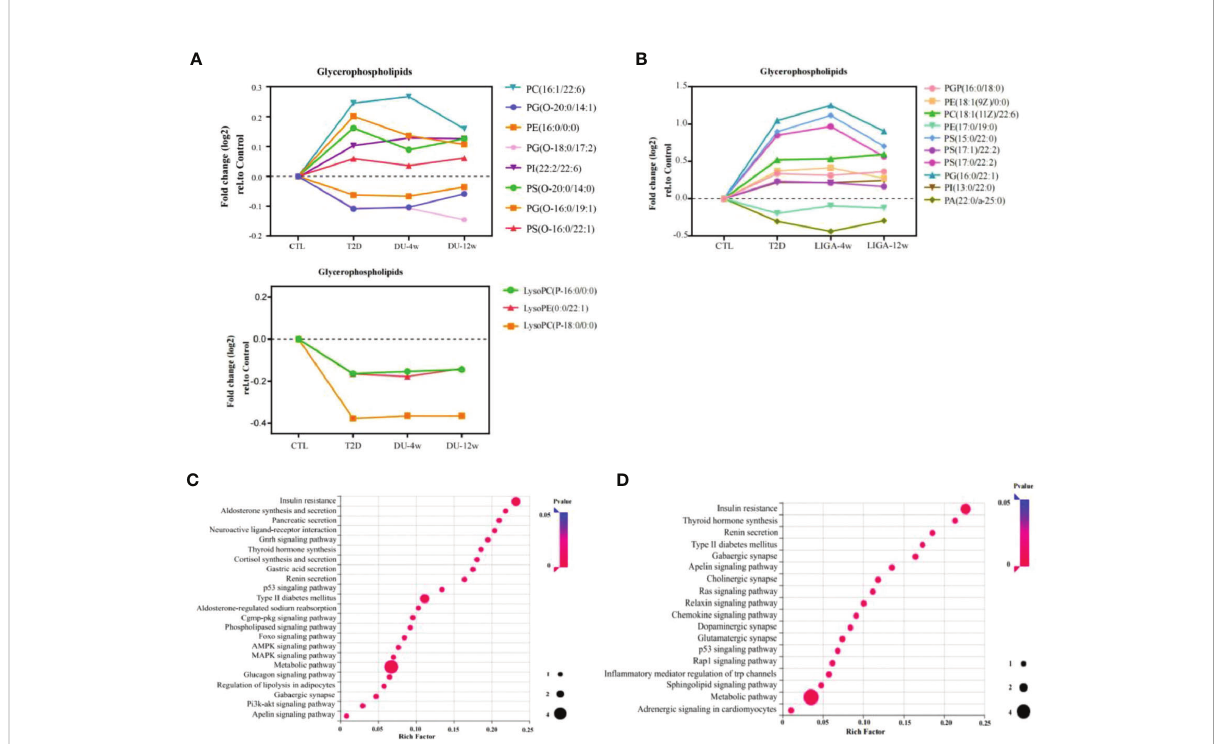
FIGURE 5 Integrating longitudinal analysis concurrent with diabetes case-control status to reveal GLP-1RAs-associated metabolic pathways and potential targets. (A, B) Longitudinal trajectories of signi fi cant metabolites involved in glycerophospholipid metabolism in response to DU and LIGA, respectively. (C, D) Regulated pathways associated with DU (C) and LIGA (D) . DU, dulaglutide; LIGA,